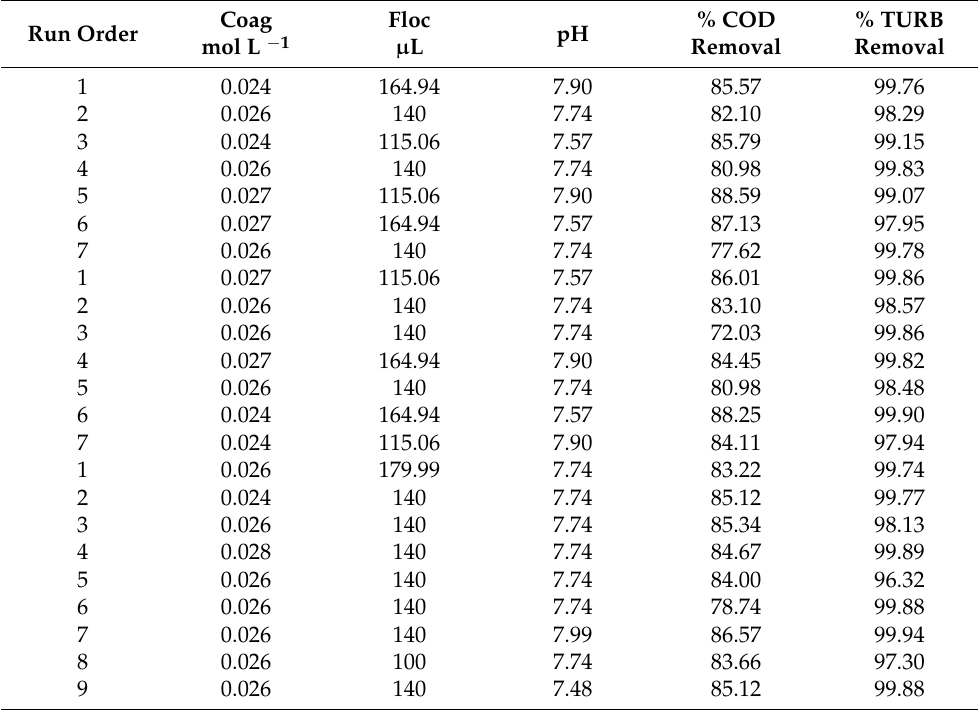
Table 4. Composition of various experiments of the central composite design, COD reduction, and turbidity removal responses for pig slurry